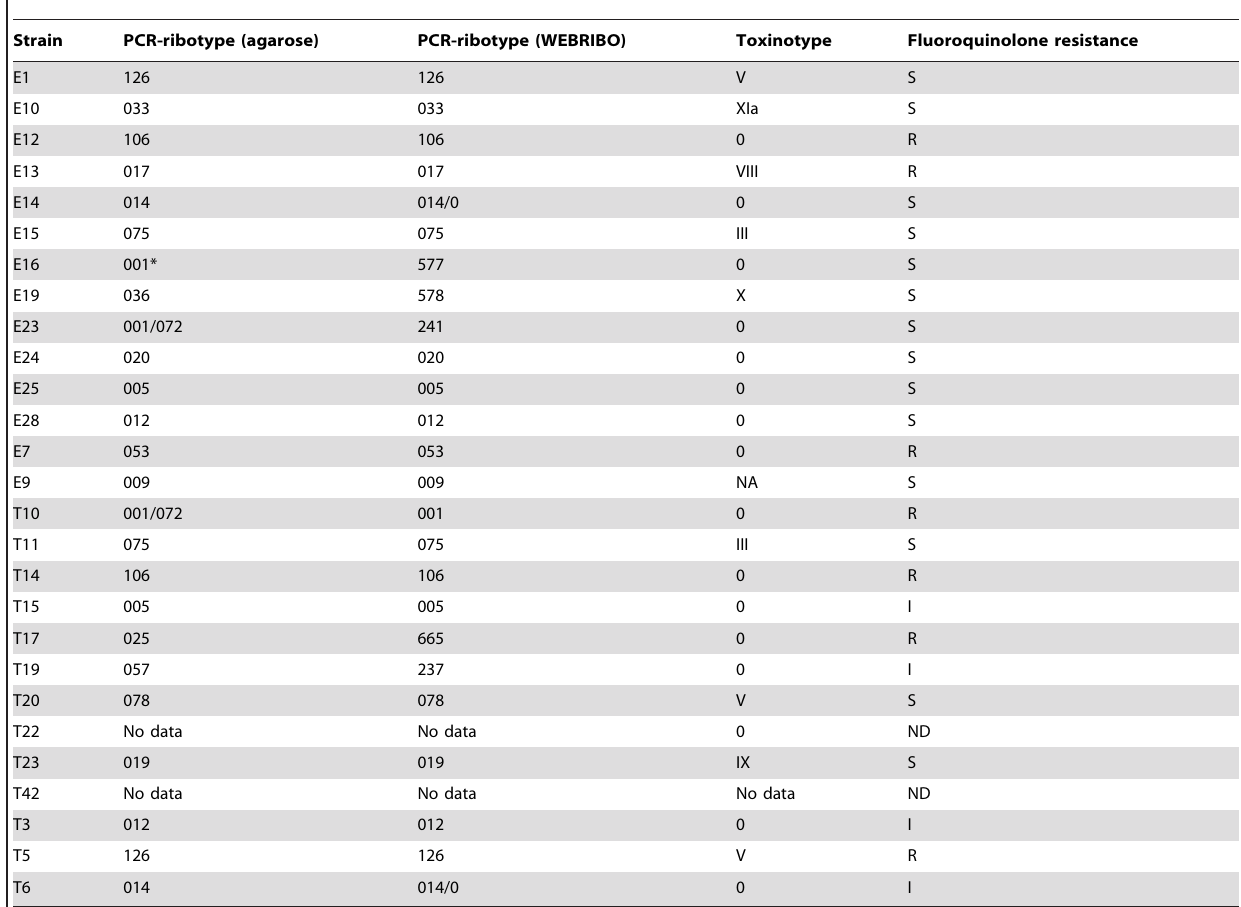
Table 3. Phenotypic description of the 27 C. difficile strains sequenced for this study.